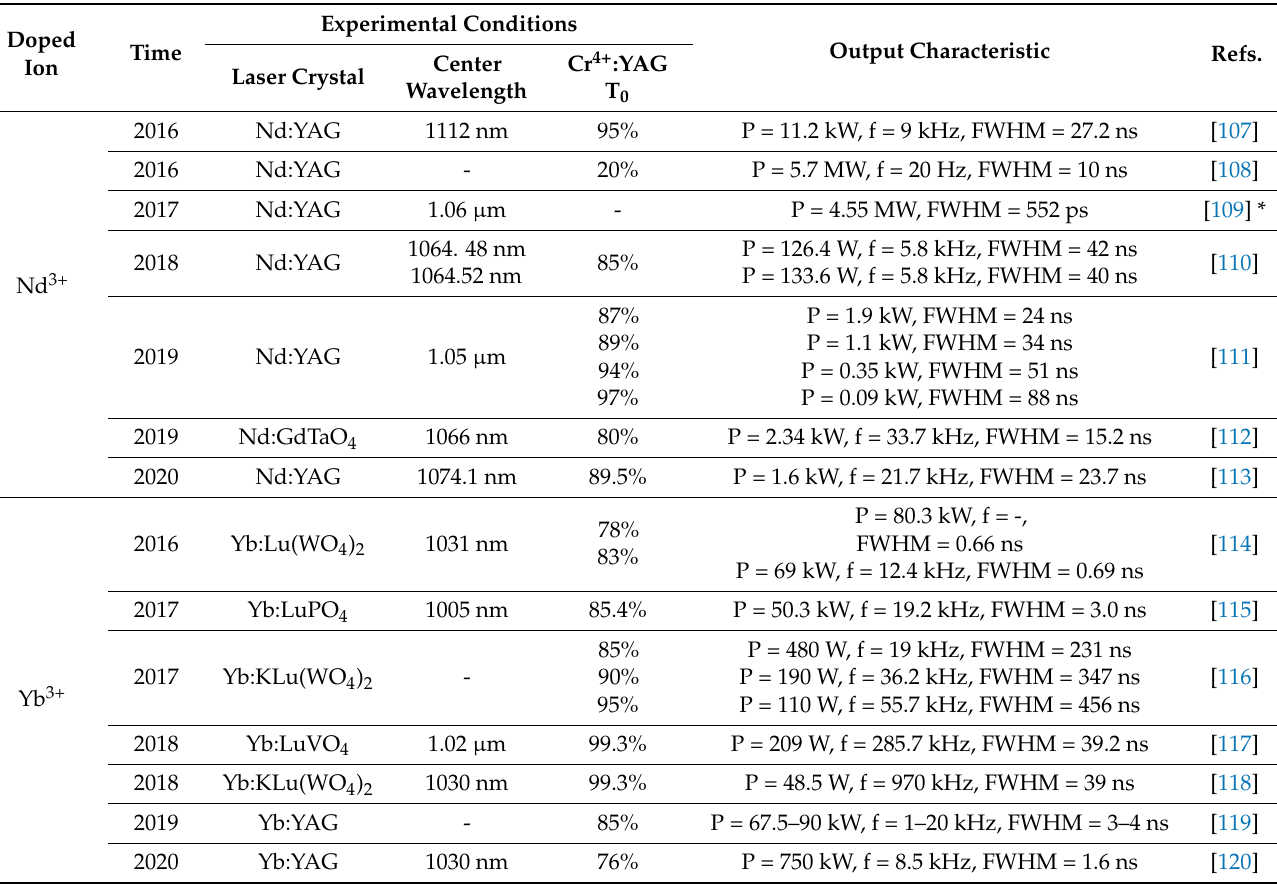
Output Characteristic Refs.